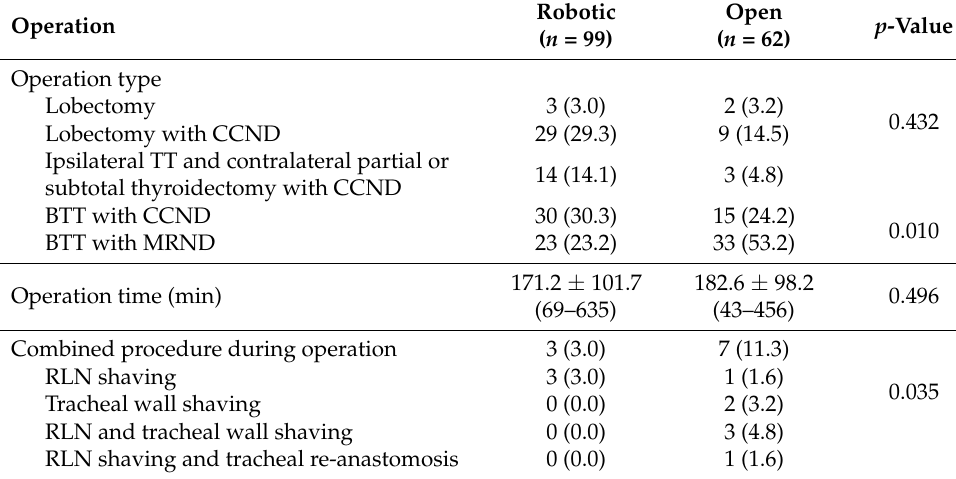
Table 2. Comparison of operation type and intraoperative outcomes between patients treated with robotic and open